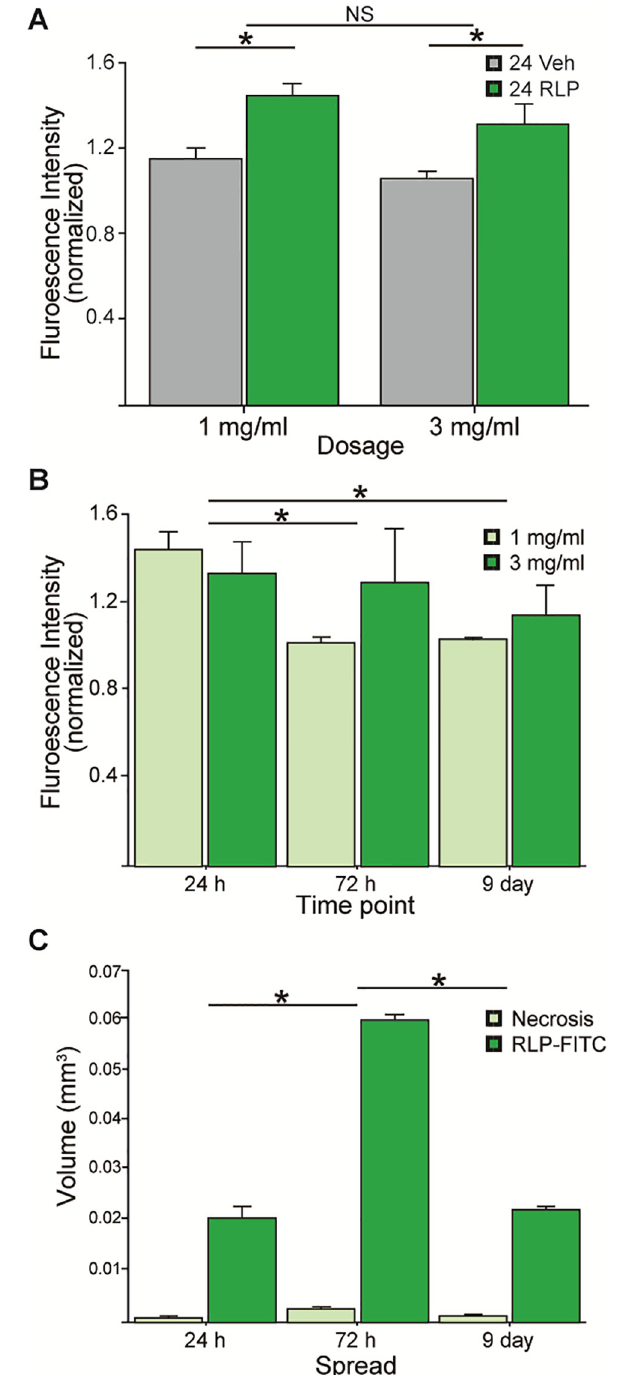
Fig 4. Quantifying changes in radioluminescent particle signal over time. A) mean background-normalized fluorescence intensity of the fluorescein (FITC) channel across the entire M2 region compared to the contralateral saline vehicle-injected side was significantly greater (p < 0.05), whereas no differences were observed between 1mg/ml and 3mg/ml groups (p > 0.05). B) Time course data showing control-normalized RLP-fluorescein (FITC) fluorescence intensity at 1mg/ml and 3mg/ml doses at each 24hr, 72hr and 9 days post-injection. Significantly greater fluorescence was observed in the 24hr group compared to the 72hr and 9 day timepoints (p > 0.05). C) The volume of RLP spread and the area of necrosis for each 24hr, 72hr and 9 day time points in 1 and 3mg/ml treated animals.